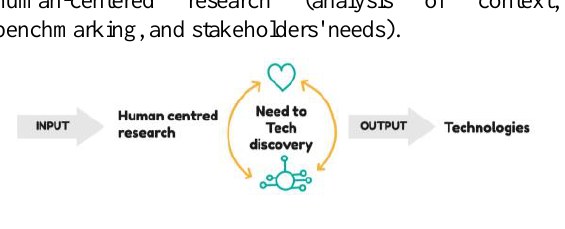
Fig. 2. N2T Input and Output